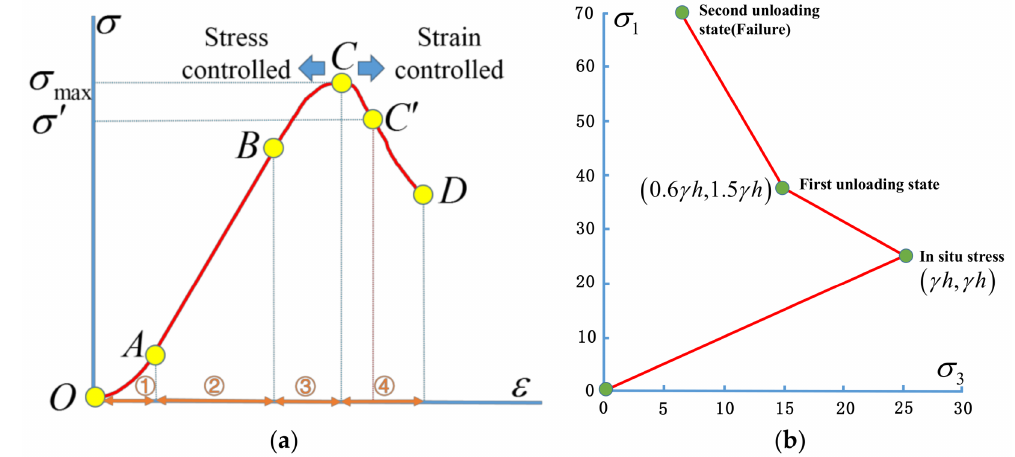
Figure 2. Stress paths for fractured sample. ( a ) Typical stress-strain curve. ( b ) Unloading paths of MTC tests. (Unit of stress: